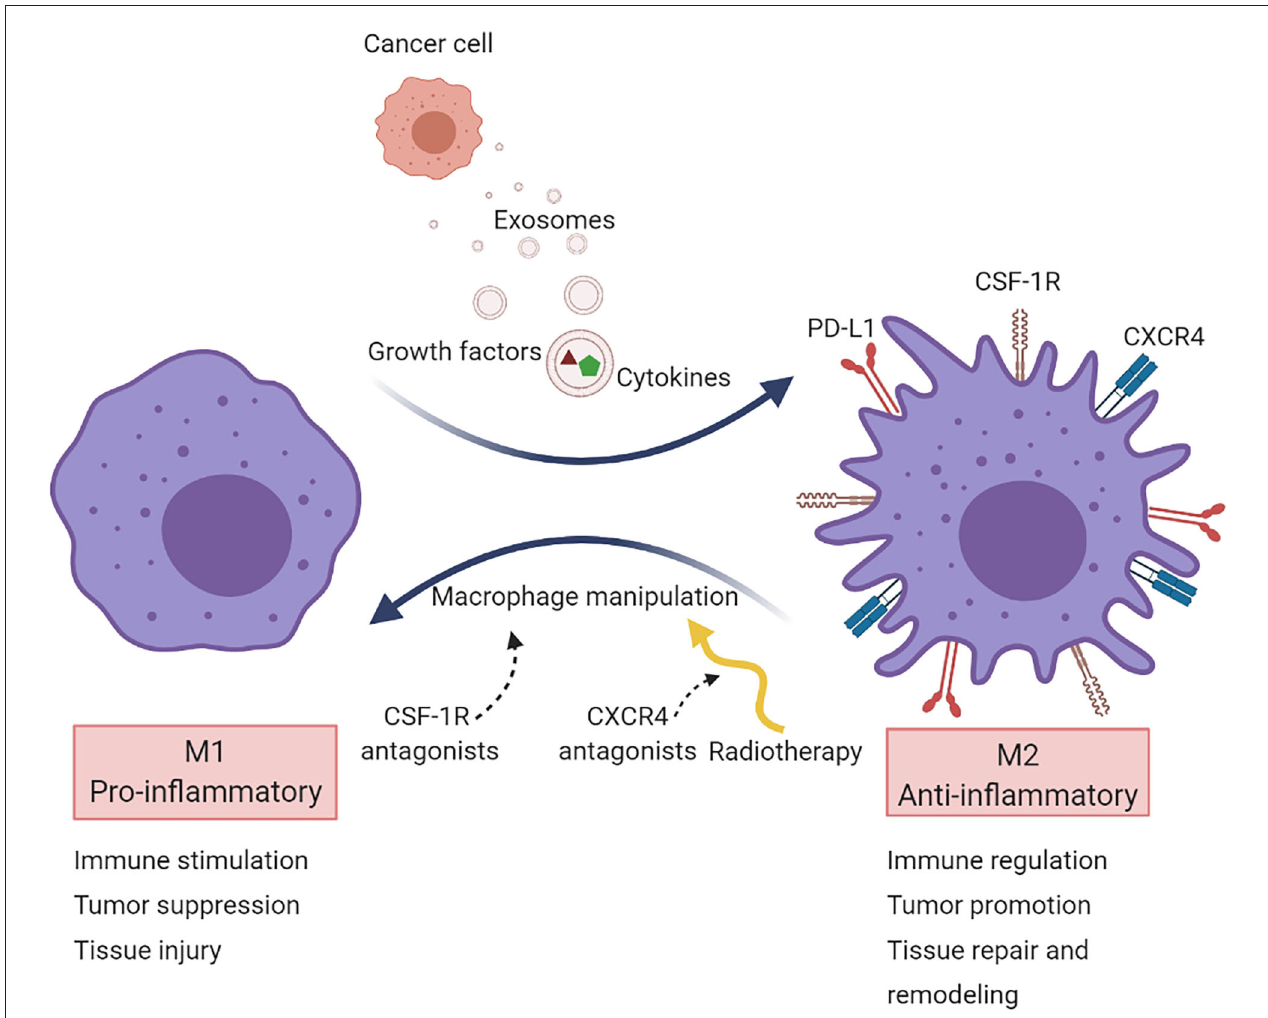
FIGURE 2 | Macrophage targeting in cancer. Macrophages are primarily recruited to tumors to acquire a pro-tumorigenic phenotype (M2 state). Several strategies target TAMs aiming to reprogram them into a pro-inflammatory phenotype (M1 state). Most macrophage-targeted therapies are focused on CSF-1R inhibitors. Another approach is via CXCR4 blockade, which acts on vasculogenesis and has been tested in the clinical setting after radiotherapy in